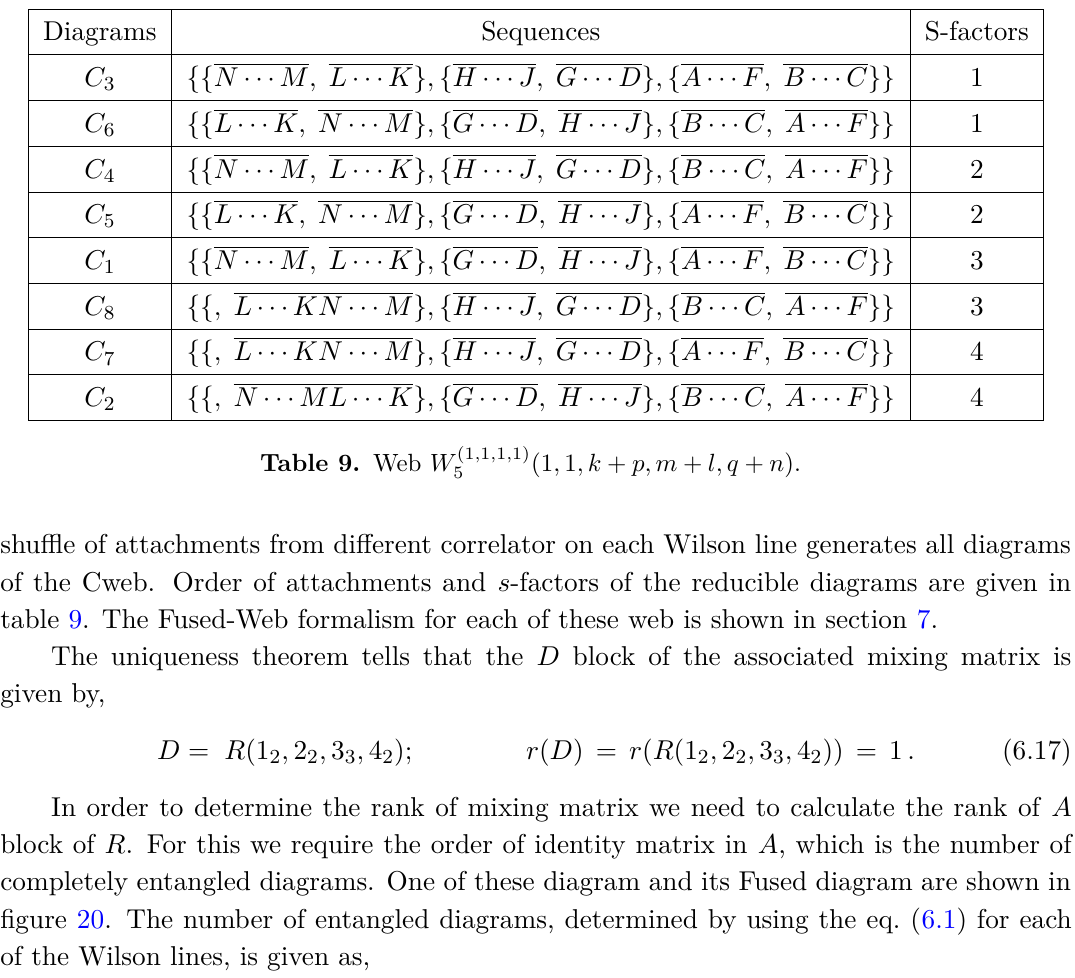
(1 , 1 , k + p, m + l, q + n ) . 5